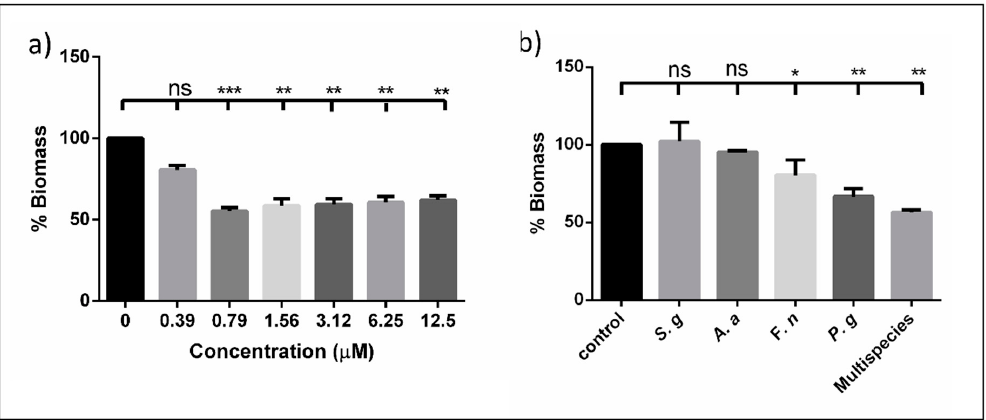
Figure 2. Effect of DMTU on biofilms. ( a ) Effect of sub-inhibitory concentrations of DMTU on multispecies biofilms shows significant reduction in biomass with BIC 50 at 0.79 µM; ( b ) shows the effect of DMTU at BIC 50 against mono-species and multispecies biofilms. Control was normalized to 100% and the significance was calculated. * denotes p ≤ 0.05, ** denotes p ≤ 0.01 and *** denotes p ≤ 0.001, ns denotes > 0.05; S.g—S. gordonii, A.a—A. actinomycetemcomitans, F.n—F. nucleatum, P.g—P. gingivalis.